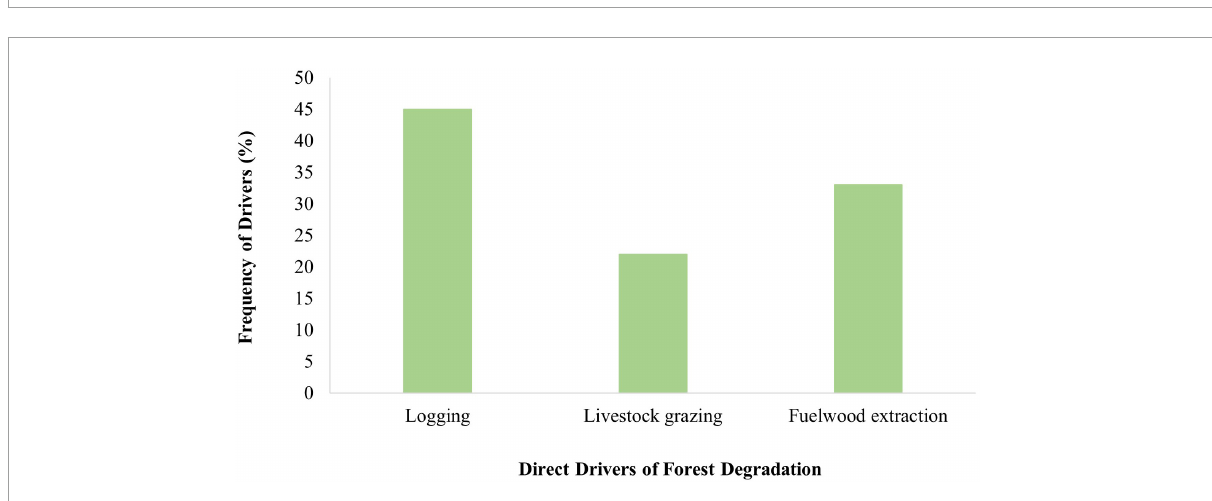
FIGURE4 Direct forest-degradation drivers specified in 29 participant countries’ R-PPs as per policymakers’